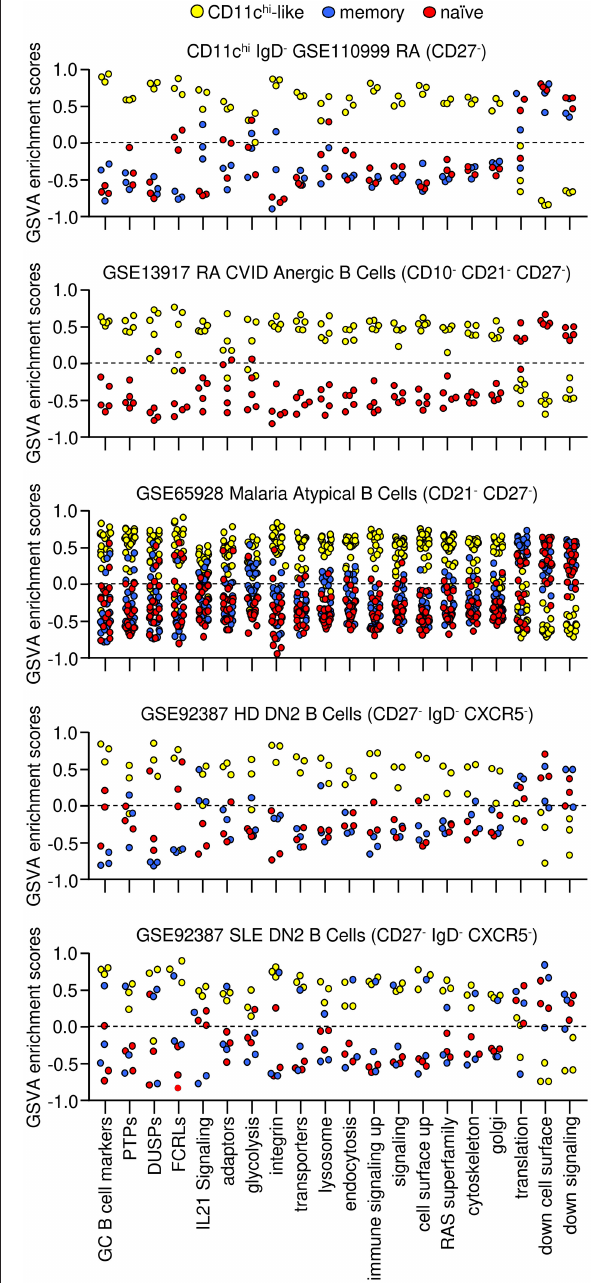
FIGURE 4 | CD11c hi -like, memory, and naive gene expression signatures from B cells isolated with different markers from patients with different diseases. Enriched signatures determined in CD11c hi B cells from SLE patients (yellow circles) were used for GSVA of B cell populations isolated by low CD21 and/or low CD27 expression to determine similarities to CD11c hi B cells. Decreased signatures are shown for memory (blue) and naïve (red) cells. GSVA was carried out on datasets from RA patients ( n = 3 of each: CD11c hi IgD − , naïve, memory), RA and CVID patients ( n = 5 of each: anergic, naïve), malaria patients ( n = 20 atypical, n = 19 naïve, n = 20 memory), HD ( n = 3 of each: DN2, naïve, memory), and SLE patients ( n = 3 of each: DN2, naïve, memory). Tukey’s multiple comparisons test was performed between B cell populations for each GSVA enrichment category of each dataset, and p -values to naïve and memory B cells are listed in Supplementary Data File 9